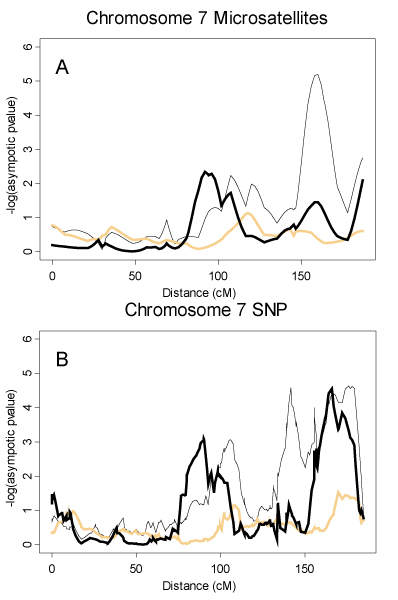
Sib-pair QTL results of P300 amplitude, stratified by smoking status. Linkage results are shown for MS markers (A, N = 735 sib-pairs) and SNPs (B, N = 718 sib-pairs). The negative log of the asymptotic p-value is plotted over distance in cM. Results are shown for the entire group (thin black line), the smoking subgroup (thick tan line), and the non-smoking subgroup (thick black line). Sample sizes in sib-pairs are 228 for MS smoking, 220 for MS non-smoking, 220 for SNP smoking, and 214 for SNP non-smoking groups.